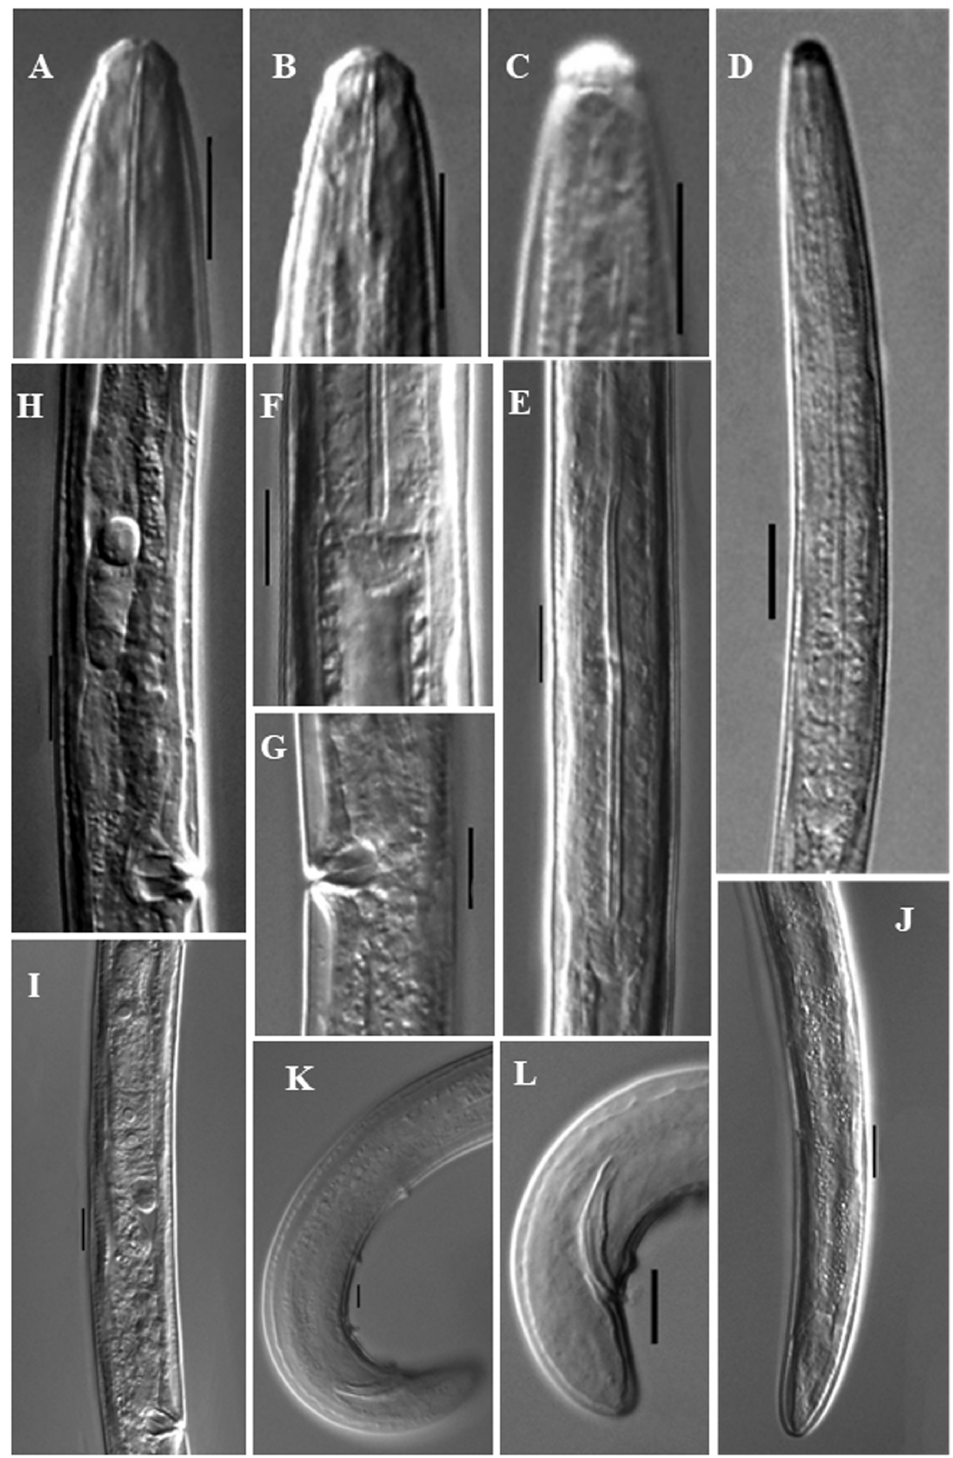
Fig. 5. Tylencholaimus ibericus Peña-Santiago & Coomans, 1994 (LM photographs). A–B . Female anterior region. C . Female anterior region showing amphid. D . Female pharyngeal region. E . Female expanded part of pharynx. F . Female pharyngo-intestinal junction. G . Vulval region. H–I . Female genital system. J . Female posterior region. K . Male posterior region. L . Male posterior end. Scale bars: A–C, E–L = 10 μm; D = 20